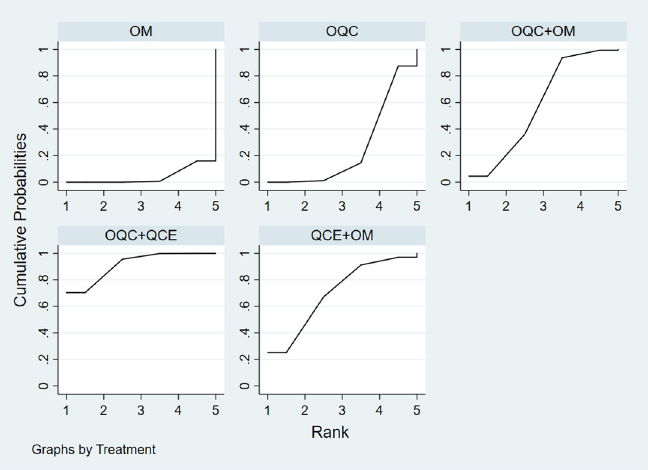
Fig 7. Surface under the cumulative raking curve of Mayo scores.